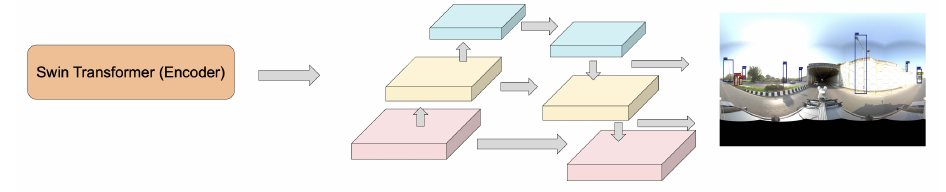
Figure 5. Our feature pyramid decoder